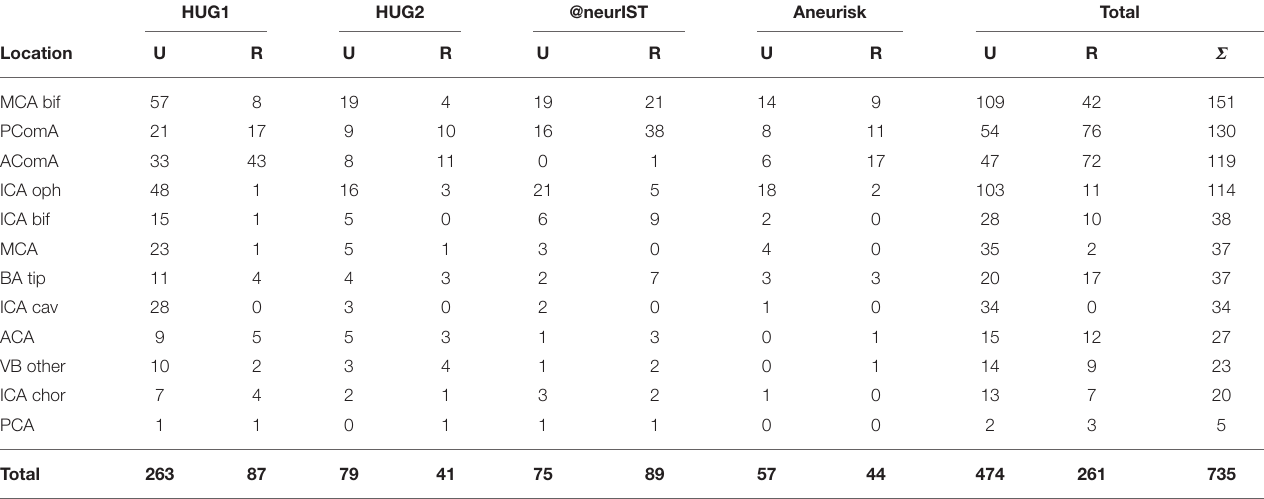
TABLE 3 | Summary of all datasets stratified by aneurysm location and rupture status.